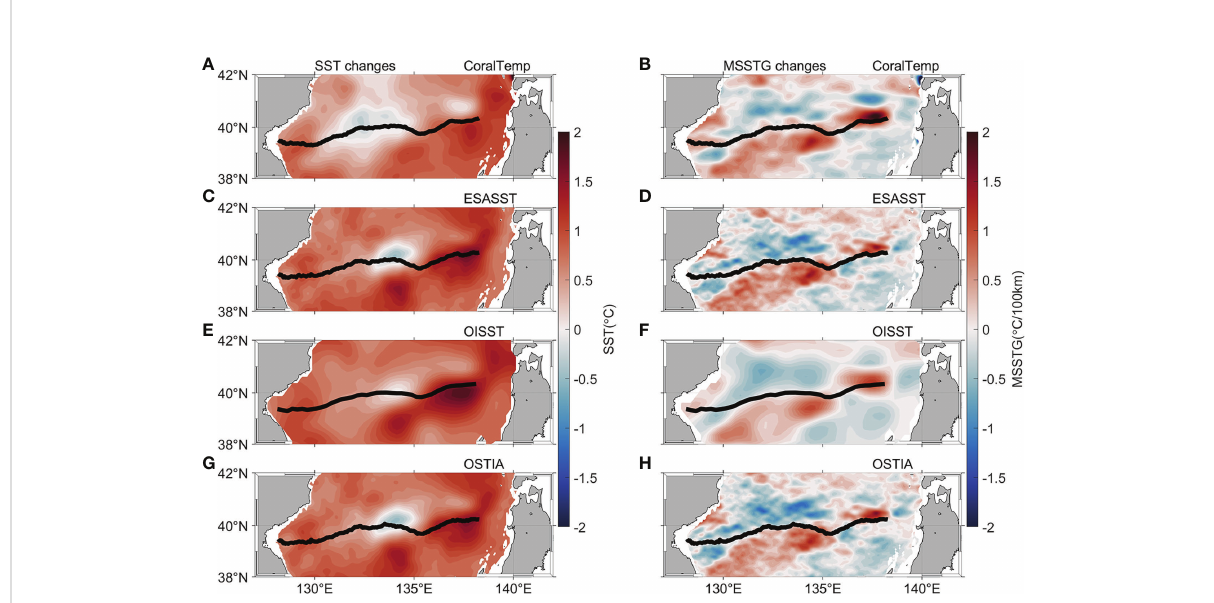
FIGURE 2 Decadal changes of (A) SST (unit: °C) and (B) the absolute value of the MSSTG (unit: °C/100km) between 1985 – 1994 and 2011 – 2020 (the latter minus the former). Shown are (left) SST (right) MSSTG based on (A, B) CoralTemp, (C, D) ESASST, (E, F) OISST and (G, H) OSTIA, respectively. Black lines indicate climatological position of the SPF during the time period of 1985 –